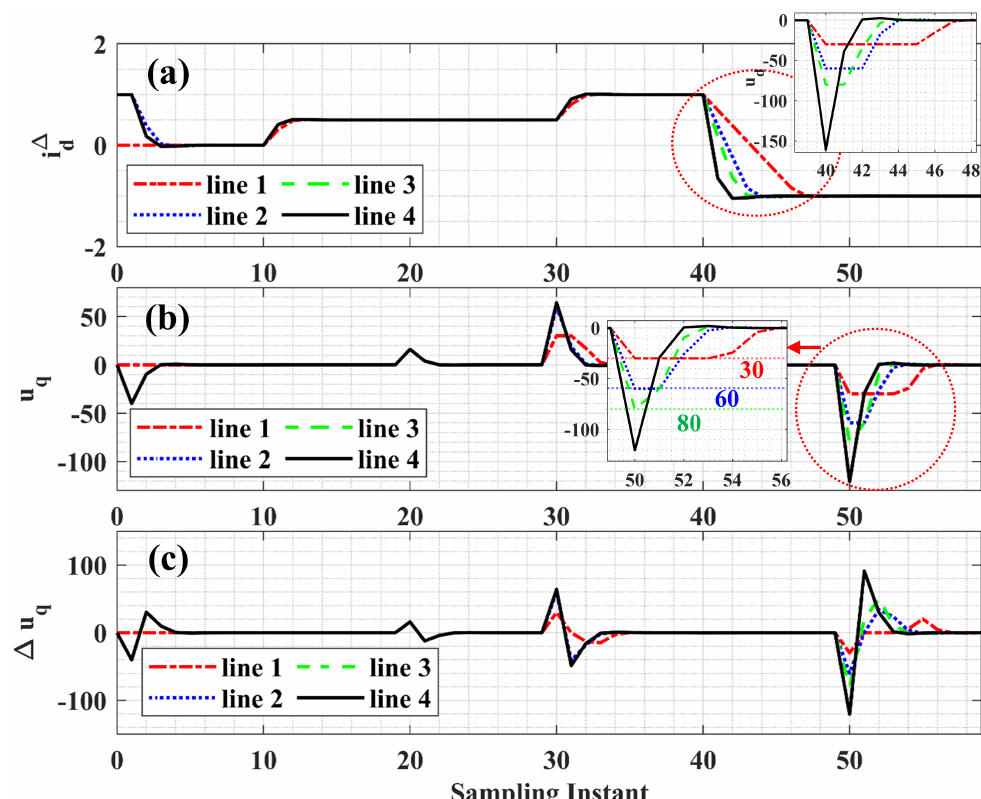
Figure 15. Case-studies with amplitude constraint: line 1 : | u d | = | u q | = 30, line 2 : | u d | = | u q | = 60, line 3 : | u d | = | u q | = 80 and line 4: